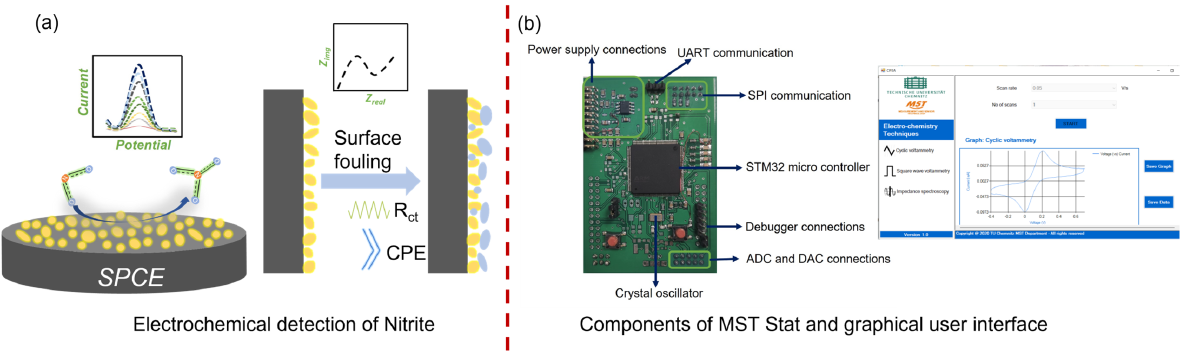
Figure 1. Graphical abstract of ( a ) Developed electrode for determination of nitrite and its surface characterization, and ( b ) The components of MSTStat and images of the graphical user interface.